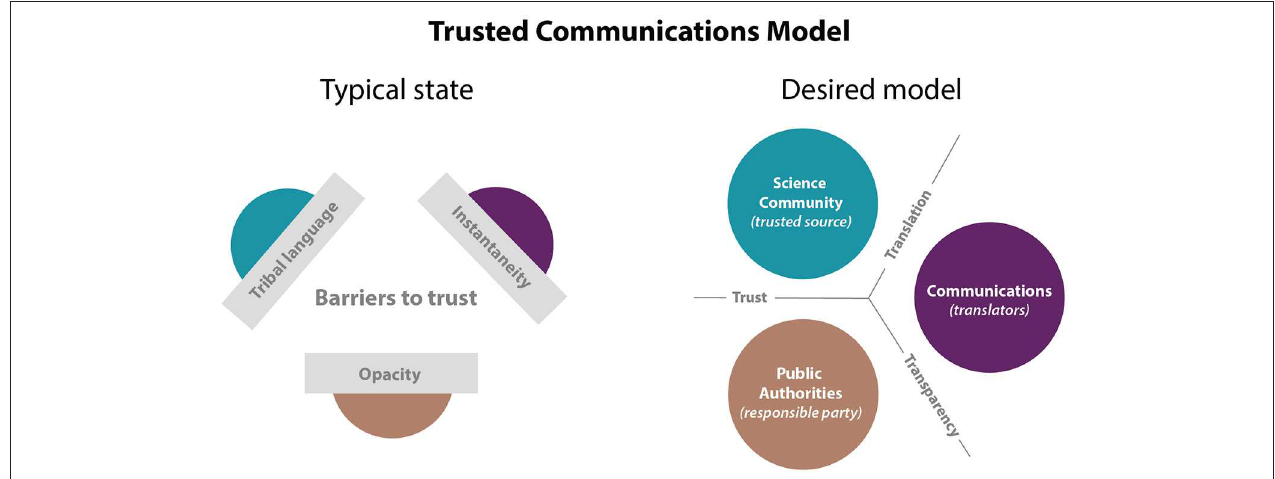
FIGURE 1 | Two communications models for transferring information on scientific research on mycotoxins to the general public. Barriers to trust often block effective communications on this